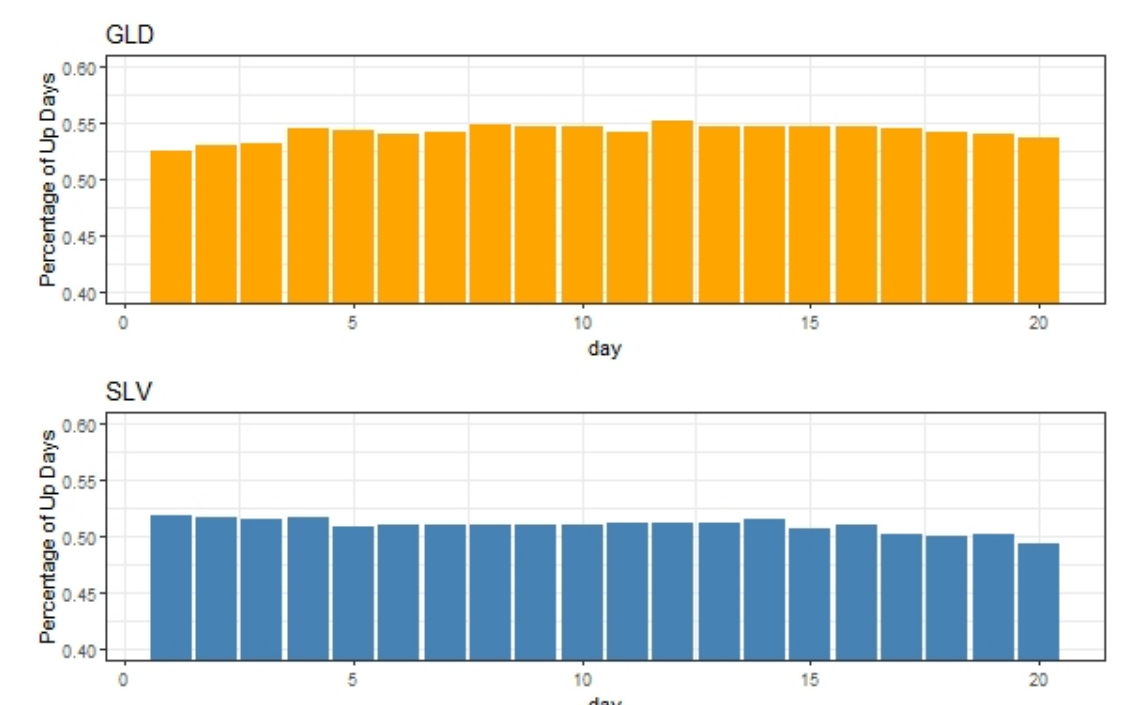
Figure 2. This figure shows histograms of gold (GLD) and silver (SLV) ETF percentage of up days. Data sourced from Yahoo Finance. Author’s own calculations.